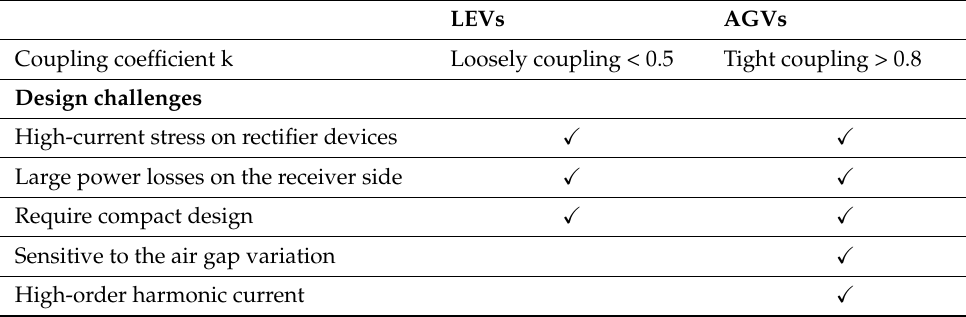
Table 6. Design challenges of low-voltage and high-current vehicles. LEVs AGVs Coupling coefficient k Loosely coupling < 0.5 Tight coupling > 0.8